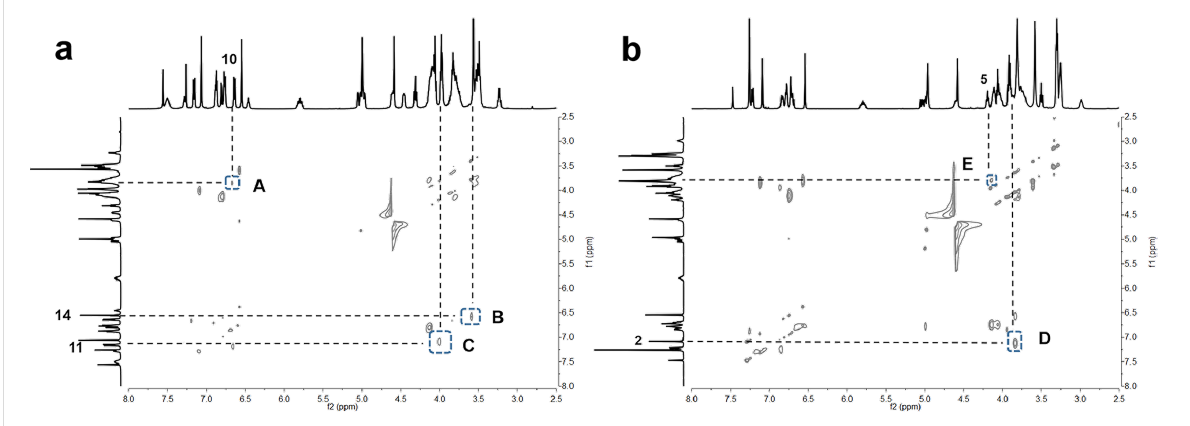
Figure 3: Partial 2D ROESY NMR spectra (500 MHz, CDCl 3 , 298 K). (a) [2]Rotaxane R1 , (b) deprotonation with addition of 2.0 equiv of DBU to (a).